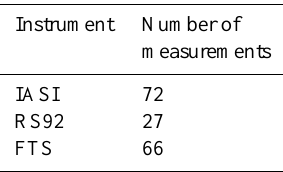
Table 3. Number of individual IASI pixel measurements, Vaisala RS92 radiosondes, and ground-based FTS measurements used for the validation exercise.